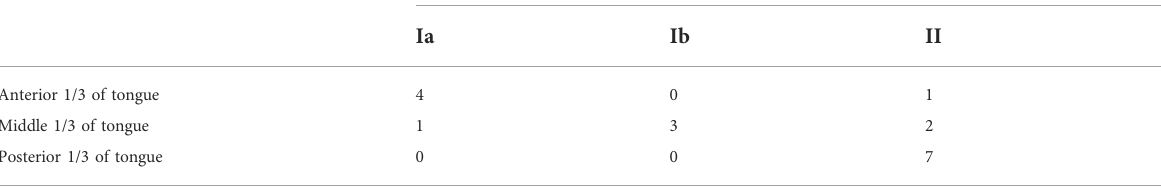
TABLE 2 (A) Distribution of the fi rst draining NIR fl uorescent LN in tongue carcinoma patients; (B) Distribution of the metastatic LNs in tongue carcinoma patients.